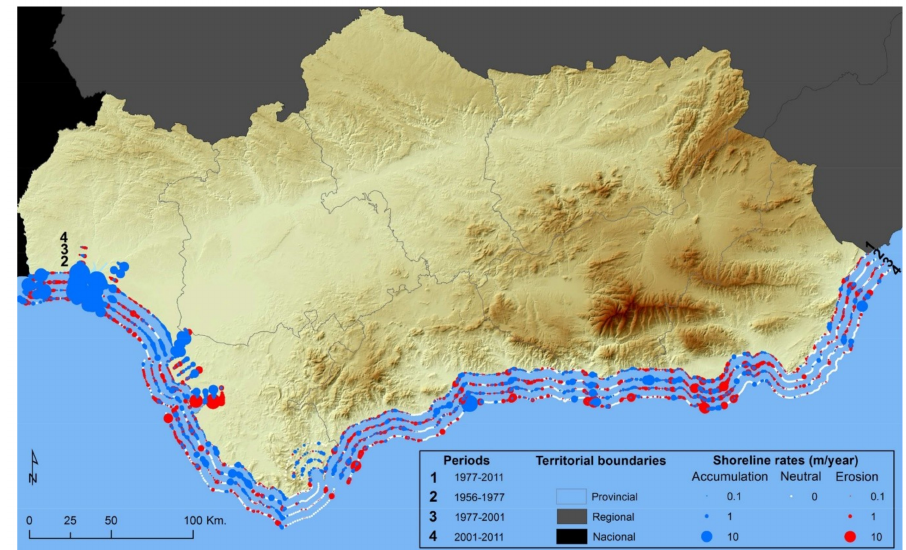
Figure 7. Overall erosion rates estimated for each kilometre of the Andalusian coast.